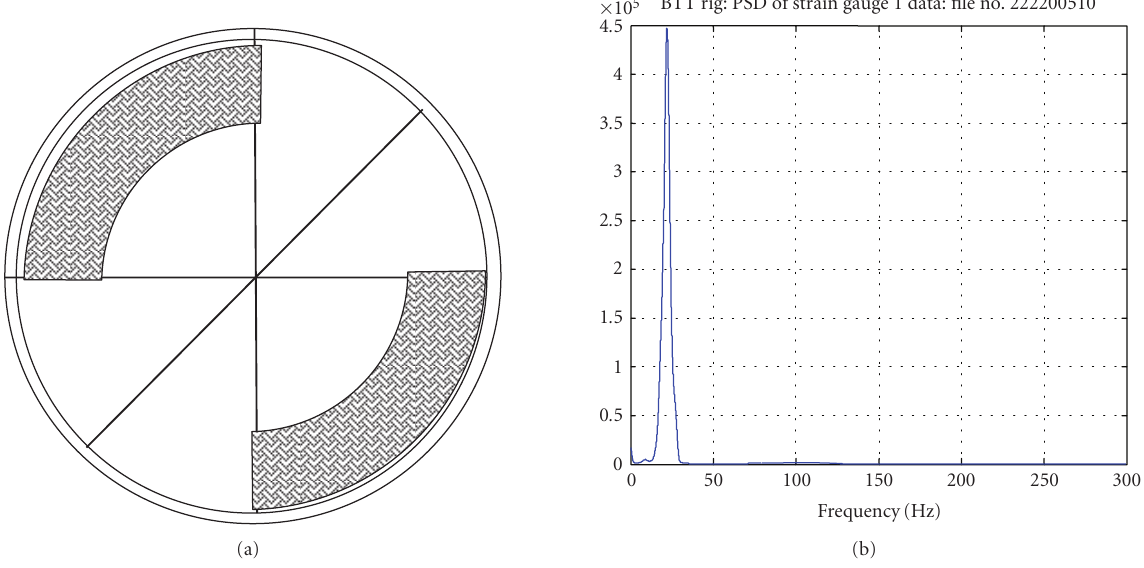
Figure 6: Two 2EO blockers (a) and power spectral density of resulting blade response